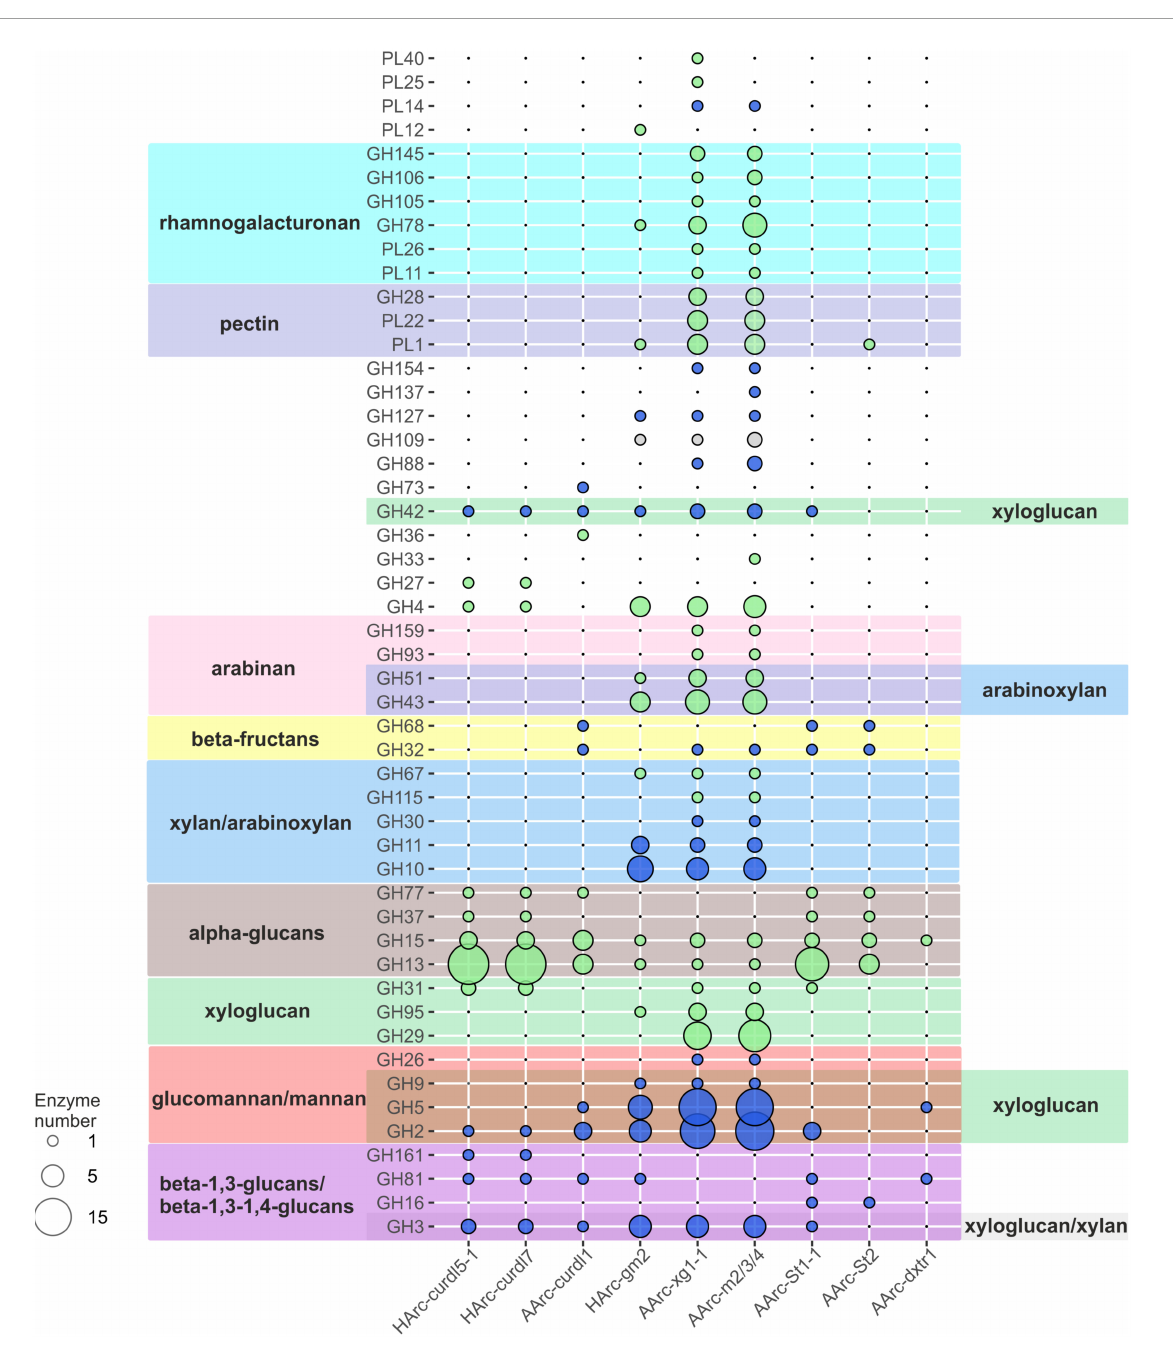
a nearly identical and the largest CAZyme sets among the studied haloarchaea. In particular, the genes encoding several endo-beta-1,4-mannosidases (five enzymes from GH5 family and one from GH26), two beta-mannosidases (GH2),